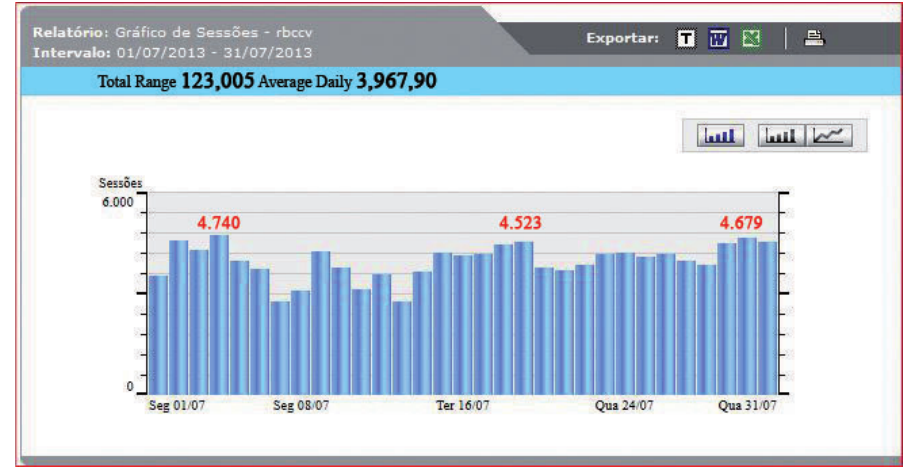
Fig. 2 - Graph with hits to BJCVS during the month of July 2013. The average is almost 4,000l hits